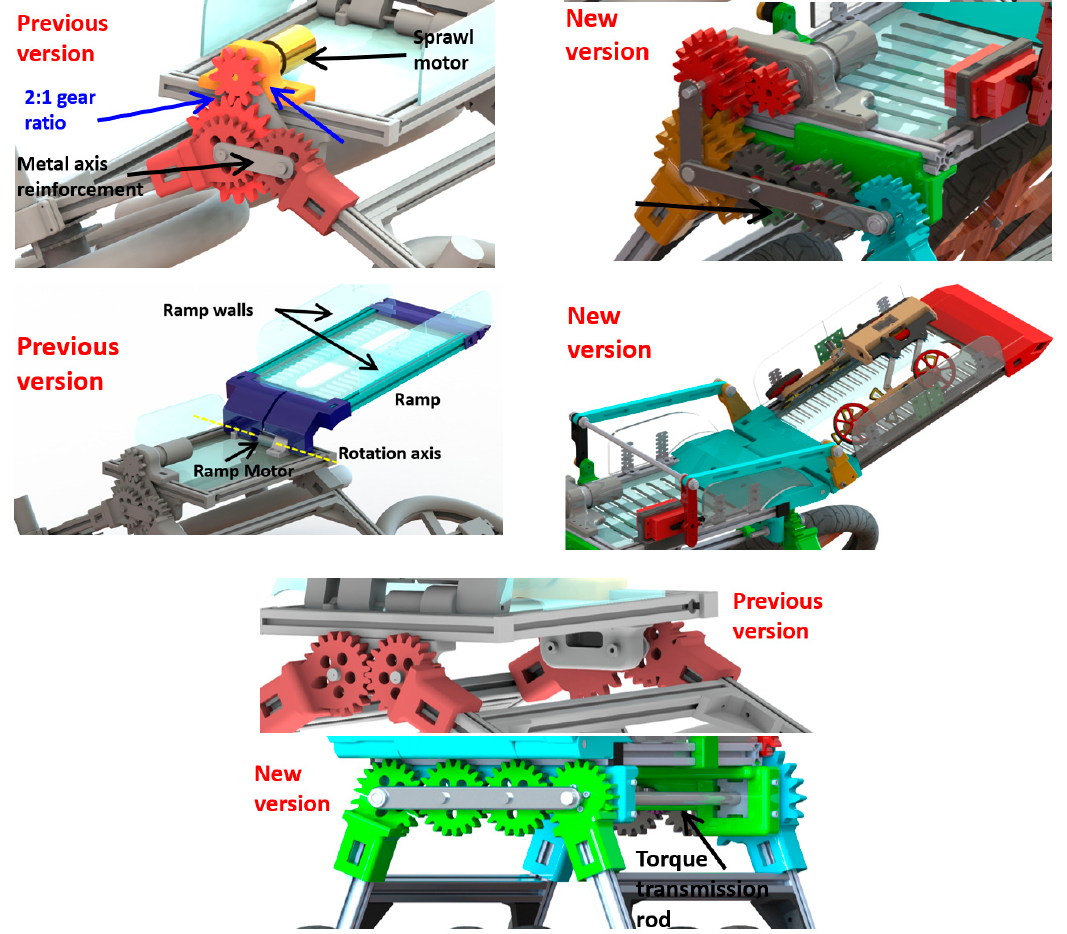
Figure A2. Comparison of the previous and new versions of the sprawl ( Top and Center ) and the ramp mechanisms ( Bottom ).